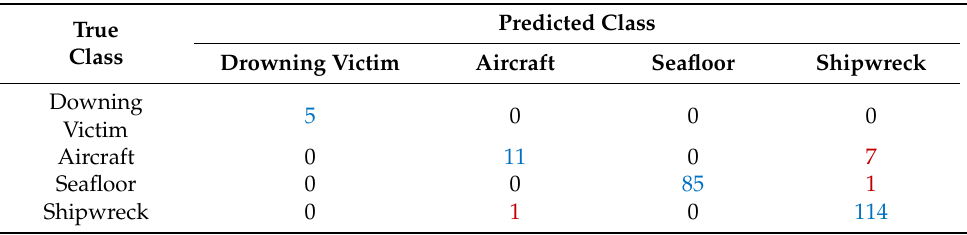
Table 3. Confusion matrix derived from fine-tuning the pre-trained vgg19 network using real side-scan sonar images.